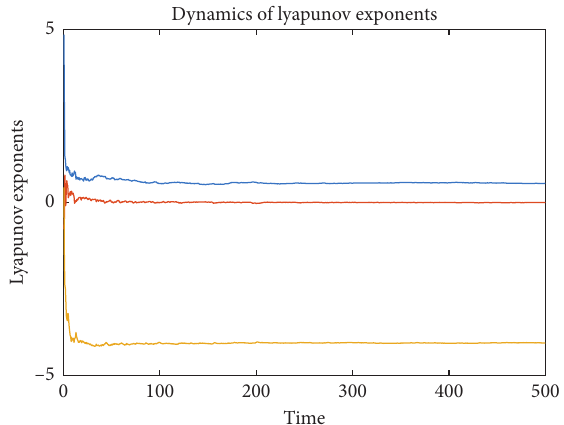
Figure 3: Lyapunov exponents of system (4).